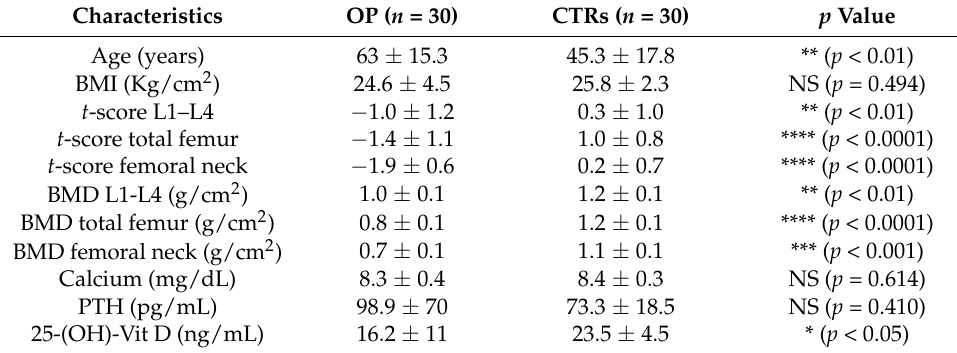
Table 1. Clinical characteristics of OP patients and CTR